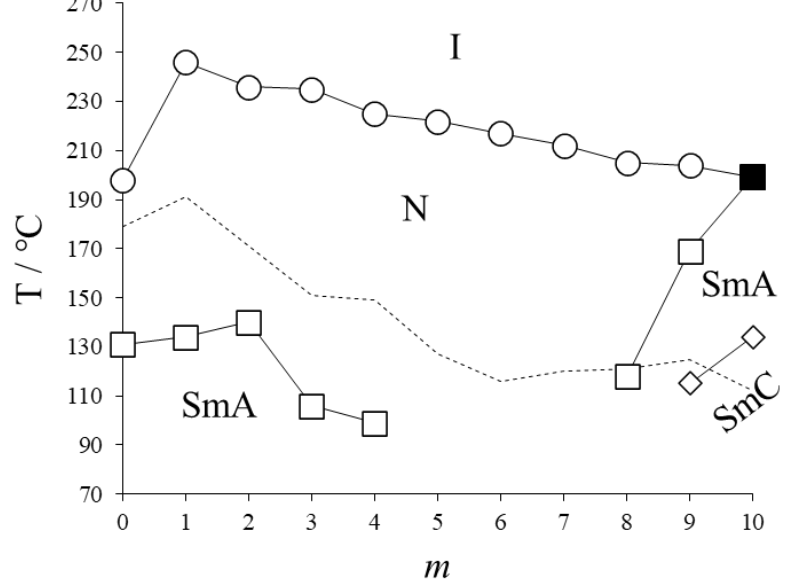
Figure 5. The dependence of the transition temperatures on the number of carbon atoms, m , in the terminal chain for the CBO4O. m series [18]. The broken line joins the melting points. Filled squares denote T SmAI ; unfilled squares T SmAN ; circles T NI ; unfilled diamonds T SmCSmA .